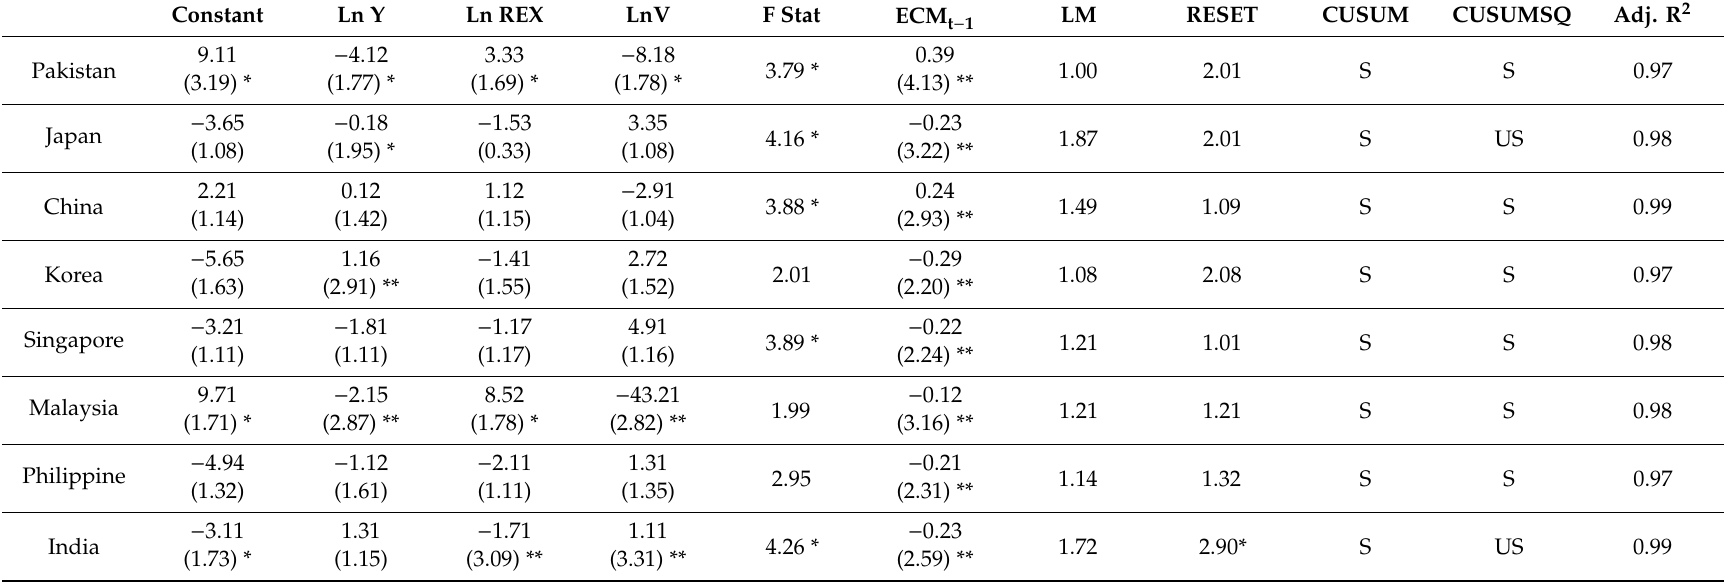
Table 4. Long-Run Coe ffi cient Estimates and Diagnostic Statistics Associated with the Linear Import Demand Models in Table